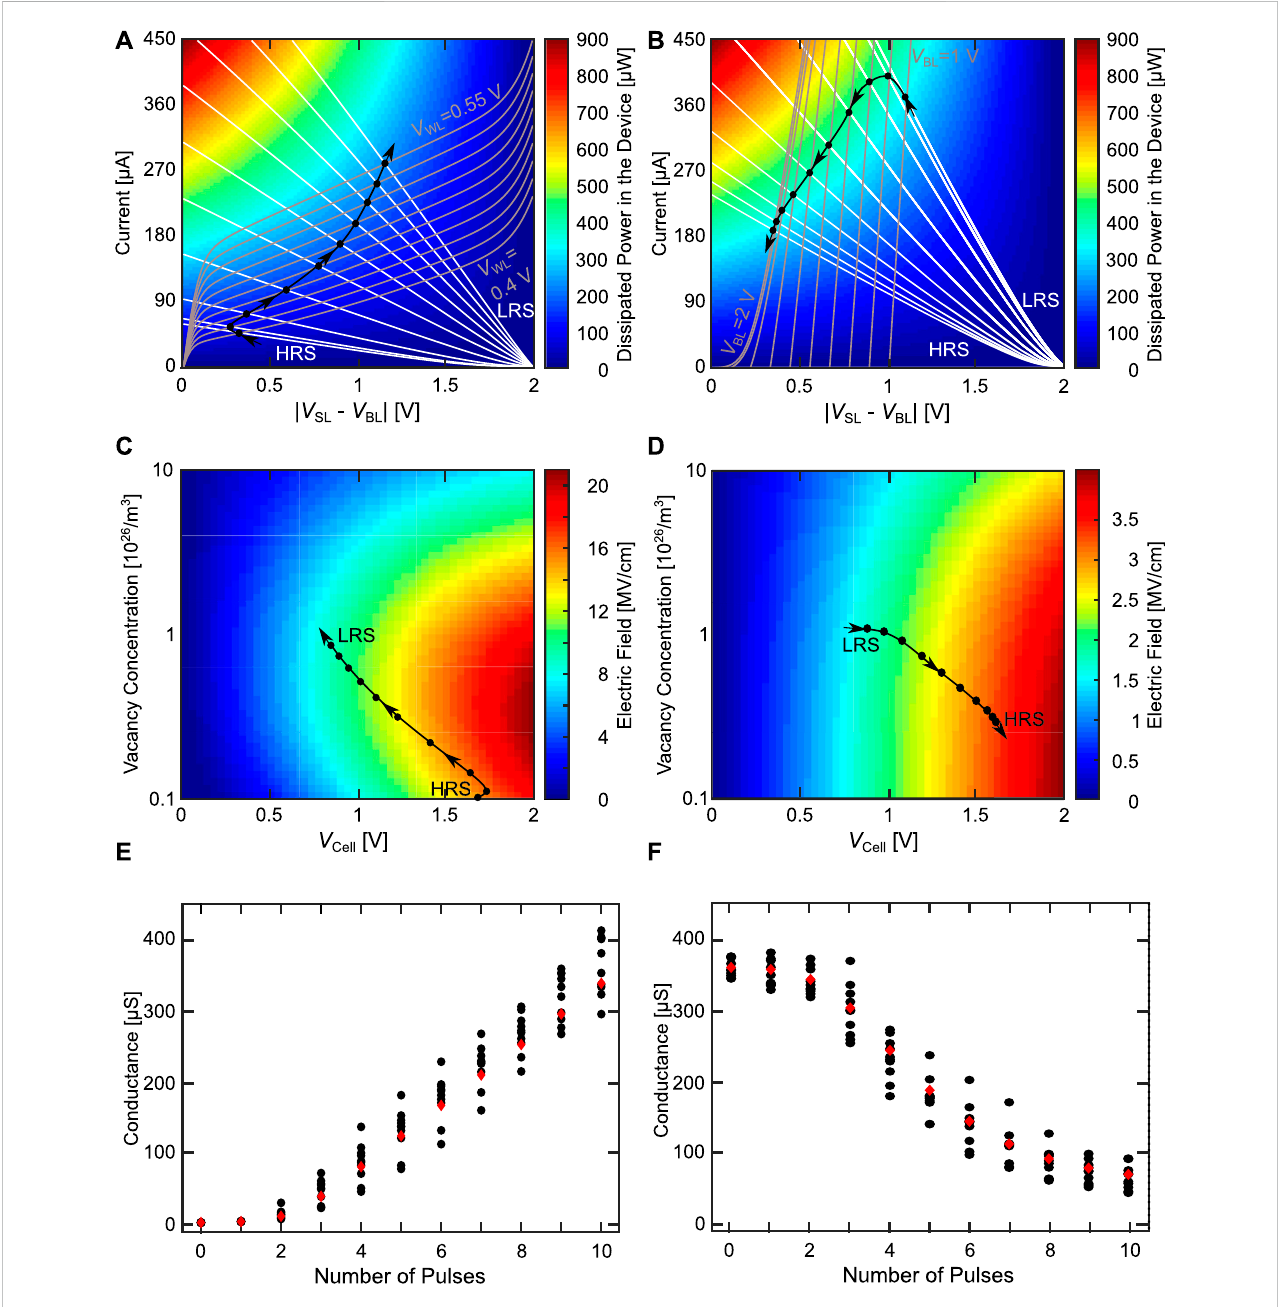
FIGURE 12 Con fi gurationAEforthepotentiation (A,C,E) anddepression (B,D,F) direction. (A,B) showstheloadlineanalysiswiththepowerdissipatedinthedevice in the background. (C, D) show the development of the cell voltages at the different device states with the electric fi eld driving the ionic motion in the background. (A,D) areusingthedeterministicmodelparameters.In (E,F) thedeterministicconductanceevolution(reddiamonds)isshowntogetherwithten runs exhibiting d2d and c2c variability (black